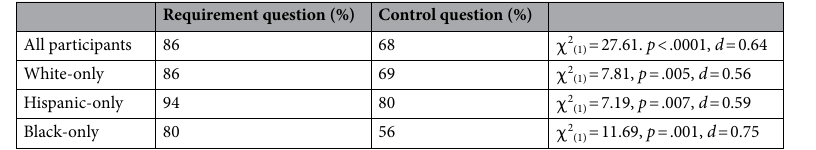
Table 2. Responses to requirement and control questions: Study